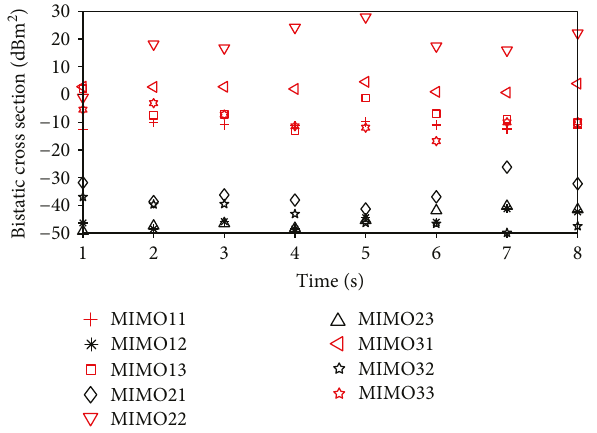
Figure 16: Retrieved RCS values of cuboid candles by means of MIMO.